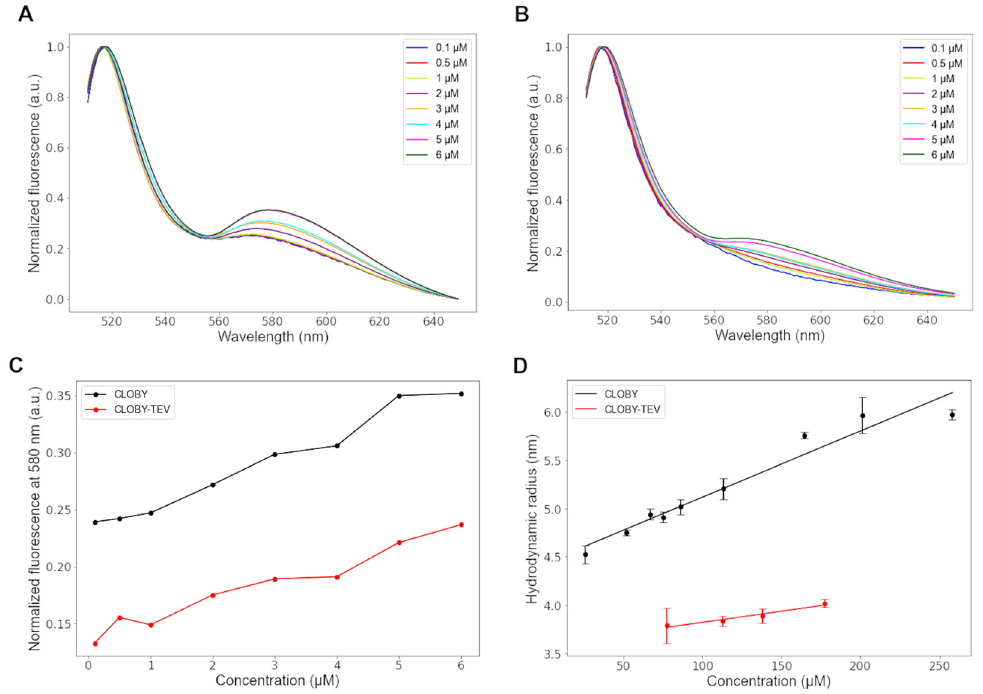
Figure 3. Concentration dependence of the normalized fluorescence of CLOBY ( A ) and TEV-treated CLOBY ( B ). The comparison of CLOBY and CLOBY-TEV presented in panel ( C ) highlights that the intermolecular FRET in the two samples is the same, and that intramolecular FRET dominates the fluorescence spectra at the 1 μ M concentration used for screening experiments. The hydrodynamic radius measured by dynamic light scattering ( D ) at much higher concentrations (up to 275 μ M for intact CLOBY) is also concentration dependent and provides an estimated dimer dissociation constant of 0.7 mM, confirming that self-association is negligeable at the working concentrations used in this study.